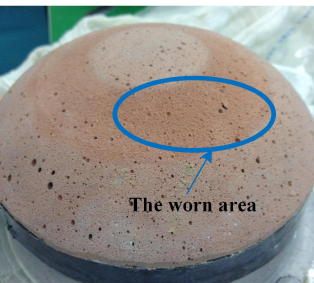
Figure 8. The polishing pad becomes worn when the H-axis speed reaches 1500 rpm with the polishing spot size of 25 mm.